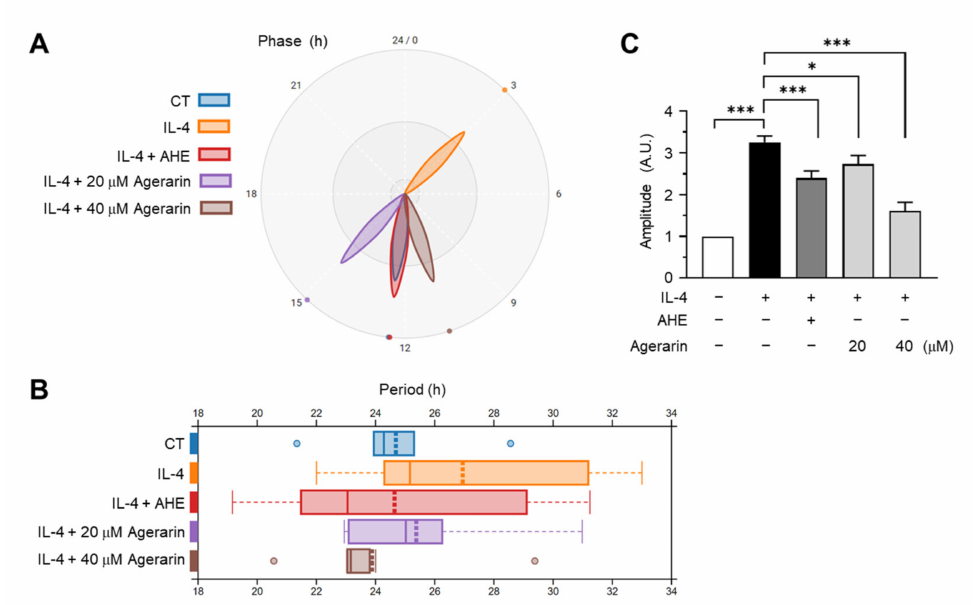
Figure 7. Real-time bioluminescence of the PER2:luc2P reporter. HaCaT/PER2:luc2P cells seeded in 96-well plates were synchronized with 100 µ M Dex for 2 h, after which the medium was replaced with the recording phenol-free medium containing 1% fetal bovine serum and 1 mM luciferin. Real-time bioluminescence of the PER2:luc2P reporter was measured and recorded every 20 min for 90 h using Spark10M. ( B – D ) After synchronization with 100 nM Dex, HaCaT/PER2:luc2P reporter cells cultured on 96-well plates were treated with 20 ng/mL IL-4 in the presence (+) or absence ( − ) of 20 µ g/mL AHE or agerarin (20 and 40 µ M). Real-time bioluminescence of the PER2:luc2P reporter was measured using Spark10M. The phase ( A ), period ( B ), and amplitude ( C ) of the bioluminescence of the PER2:luc2P reporter were analyzed using Biodare2. * p < 0.05; *** p < 0.001 ( n = 12) by Sidak’s multiple comparisons test. CT, synchronization only control; A.U., arbitrary